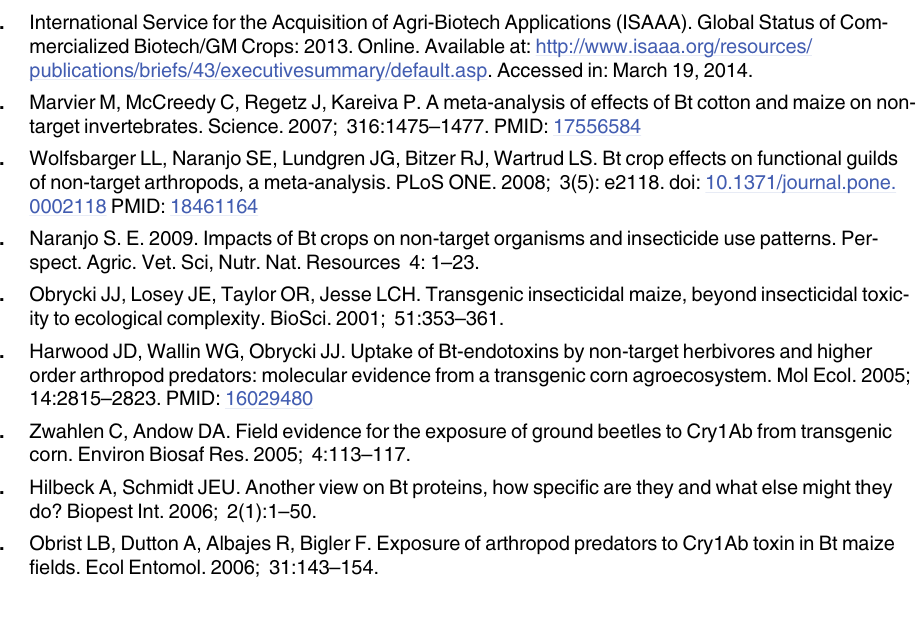
S3 Table. Mammal species records in 40 Atlantic Forest fragments surrounded by conven- tional maize (20) or transgenic maize (20) in Campos Novos, Southern Brazil. S4 Table. Dung beetle community data, mammal richness, and measurements from 40 for- est fragments in Campos Novos, Southern Brazil. First principal component (PCA1), first principal coordinates analysis of management (PCoA1) and first principal coordinates of neighbor matrices (PCNM1). C: fragments adjacent to conventional maize. T: fragments adja- cent to transgenic